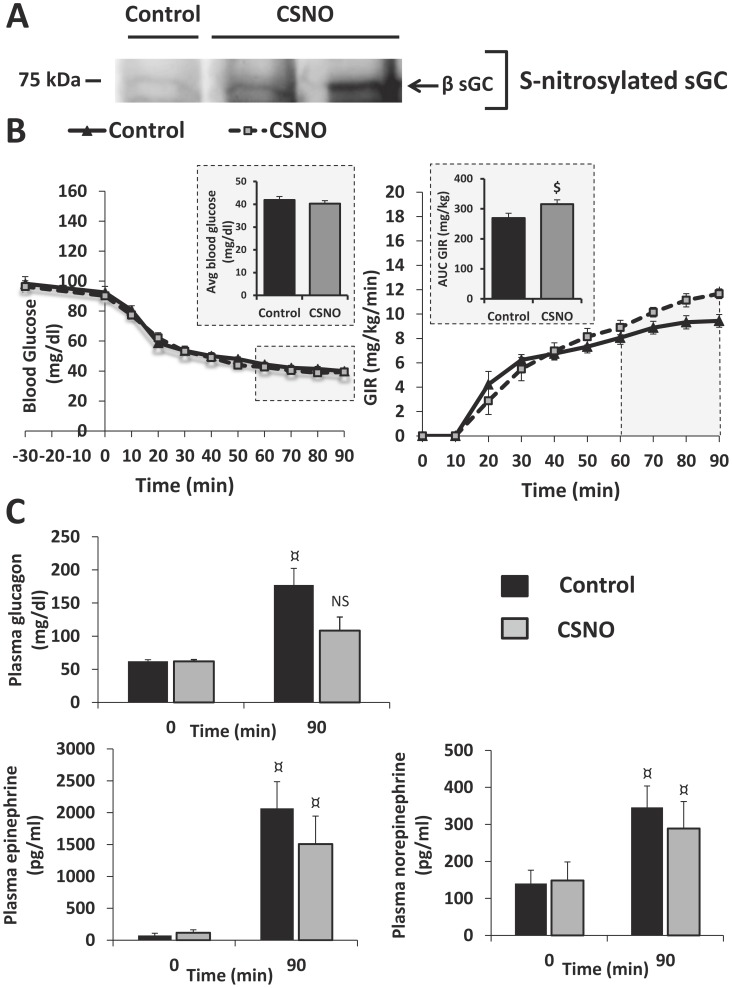
ICV CSNO injection increases VMH sGC S-nitrosylation and impairs the CRR.(A) Representative Western blot against VMH S-nitrosylated sGC from control and CSNO treated rats. (B–C) Blood glucose level (B left panel; n = 9; Inset: average blood glucose during the last 30 minutes of the clamp); glucose infusion rate (GIR; B right panel; n = 9; Inset: AUC of the GIR during the last 30 minutes of the clamp); plasma glucagon (C upper left panel; n = 5), epinephrine (C lower left; n = 5) and norepinephrine levels (C lower right panel; n = 5) during hyperinsulinemic/hypoglycemic clamp (1.2 U/kg/h) of animals injected ICV with aCSF (Control) or CSNO (0.5 mM). *: p<0.05 vs controls (Two-way ANOVA followed by Bonferoni post-hoc test); $: p<0.05 vs control (unpaired t-test); ¤: p<0.05 time 0 vs time 90 (paired t-test); NS: p>0.05 time 0 vs time 90 (paired t-test).